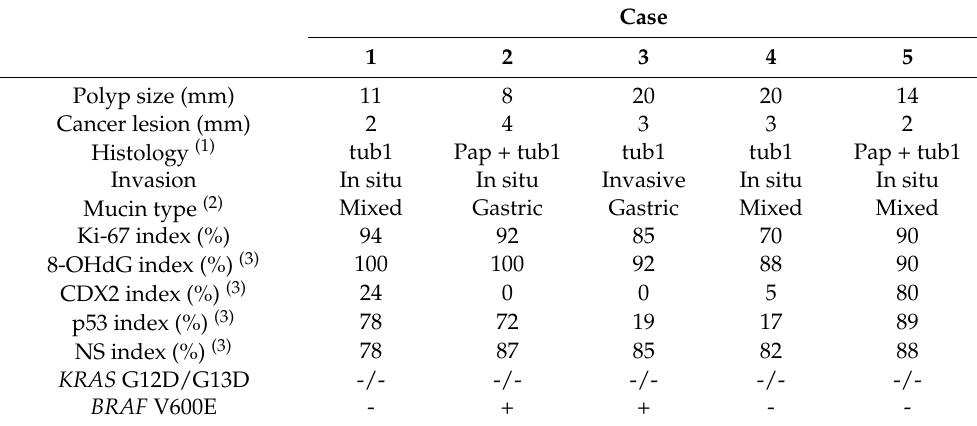
Table 3. Adenocarcinoma cases in hyperplastic